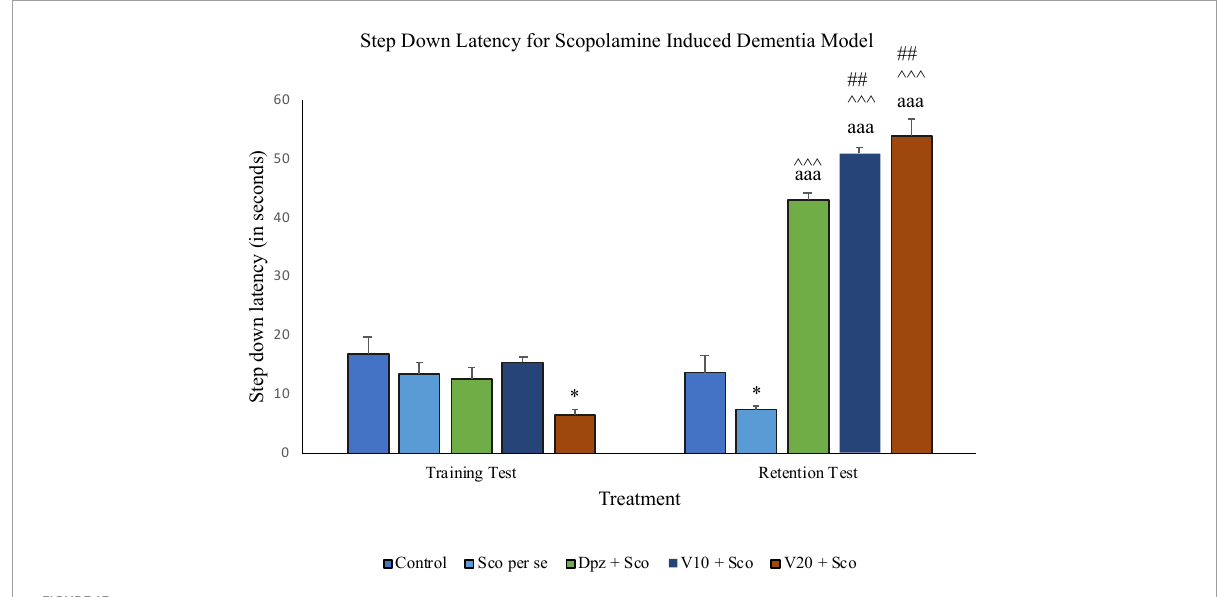
FIGURE13 Effect of vanillin and other treatments on step-down latency. Data are expressed as mean ± SEM. “*” denotes P < 0.05 with respect to the control group within the same day. “##” denotes P < 0.01 with respect to the standard treatment group within the same day. “ ∧∧∧ ” denotes P < 0.001 with respect to the negative control group (Sco per se ) within the same day. “aaa” denotes P < 0.001 with respect to the SDL of the same group on the 10th day of the